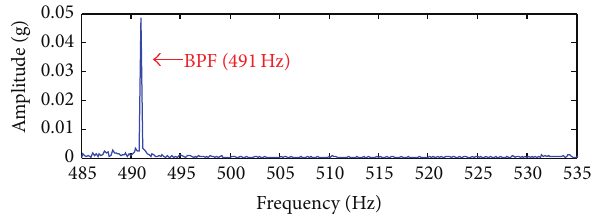
Figure 13: Zoomed-in spectrum under 16 mm crack condition.